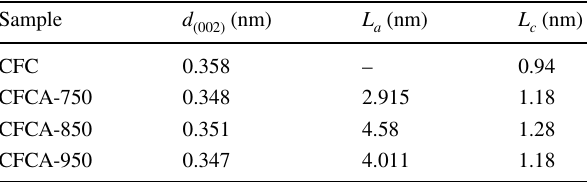
Fig. 1 XRD pattern of keratin and CFCAs Table 1 Structural properties of CFC and CFCAs